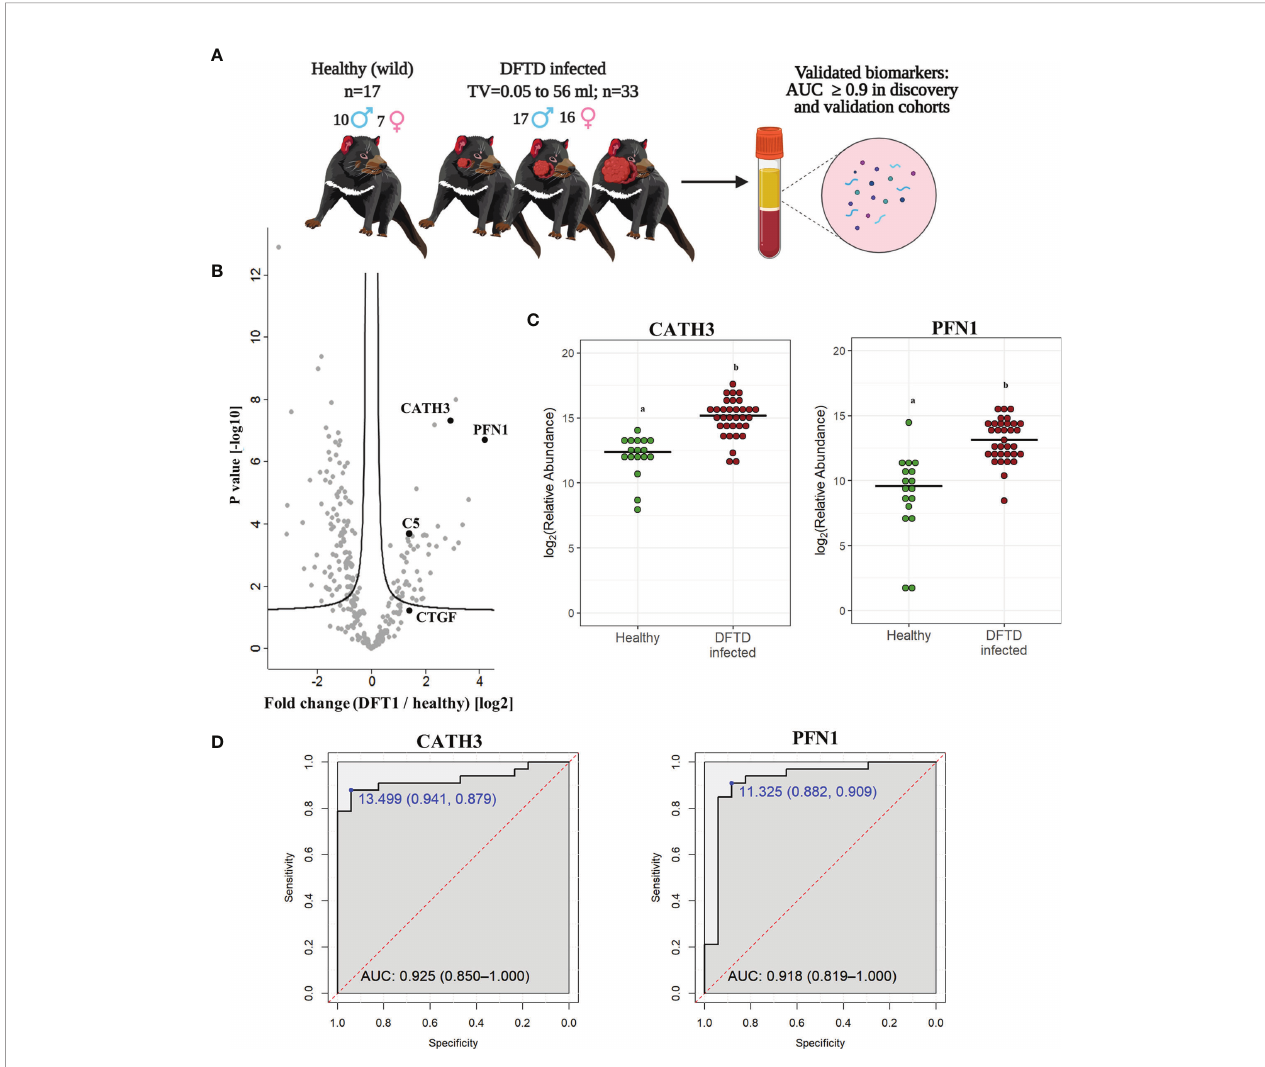
FIGURE 3 | CATH3 andPFN1 EVs as biomarkers for DFTD. (A) Isolated extracellular vesicles fromserum samples of 50 devils(33 DFTD-infected and 17 healthywild devils) were analyzed by mass spectrometryto validate potential EV sampleprotein biomarkers detected in the discoverycohort results; TV, tumor volume. (B) Volcanoplot of protein relativeabundance fold changes (log 2 ) between EVs derived fromserum ofdevils with differentstages of DFTD (n=33)and healthy wild controls(n=17) vsfold change signi fi cance. (C) Dot plotshowingthe relative abundance ofCATH3 and PFN1 in the serum EVs of 17 wild healthydevilsand 33 DFTD infected devils, different letters “ a ” and “ b ” indicatesigni fi cant differences between groups(Student ’ s t-test, FDR-corrected p < 0.05). (D) Receiver operating characteristiccurve analysis for CATH3 and PFN1 EVs (33 DFTD-infected animalsvs17 healthy controls).The dashed redline indicates random performance. The cut-off values were determinedusing Youden ’ s index andare indicated inblue at the lefttop corner of the ROC curve, and speci fi city and sensitivity are indicated inbrackets,